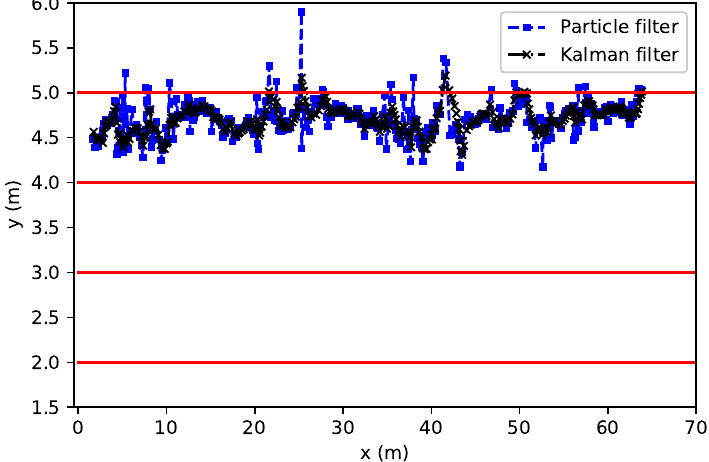
Figure 13. UWB tracking for indoor running with particle and Kalman filters in a 3-lane